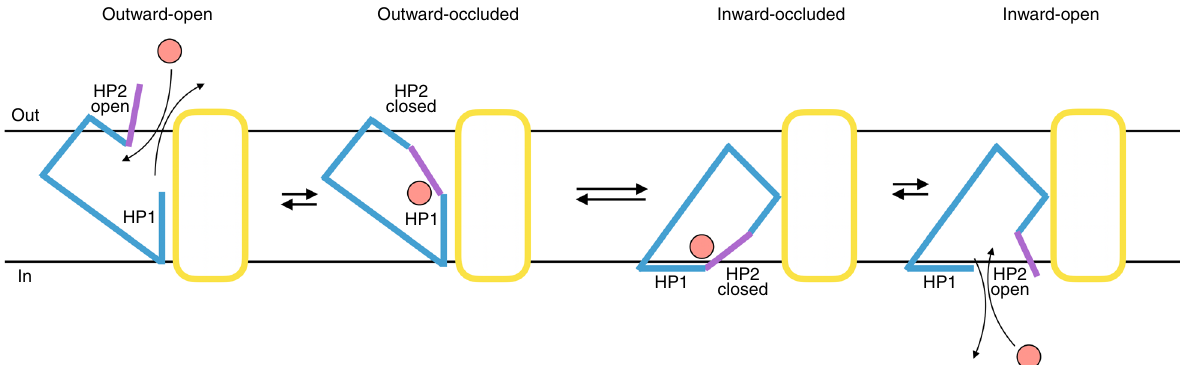
Fig. 5 One-gate elevator transport mechanism. Schematic representation of the transport cycle of SLC1A transporters, with the scaffold domain in yellow, the transport domain in blue, the extra- and intracellular gate (HP2 loop) in purple and the transported amino acid in